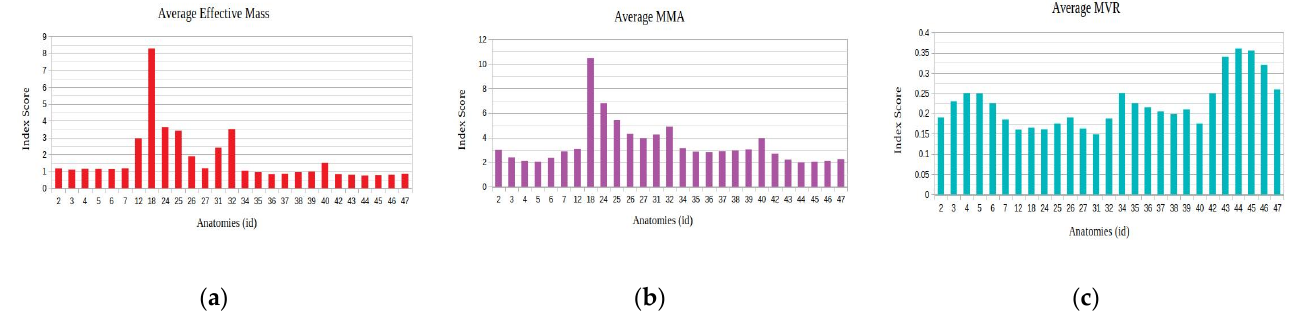
Figure 14. Derived mean index value for the selected performance indices under the available metamorphic structure anatomies, for Task 2 (( a ) with respect to the Average Effective mass index, ( b ) with respect to the Average MMA index and ( c ) with respect to the average MVR index).